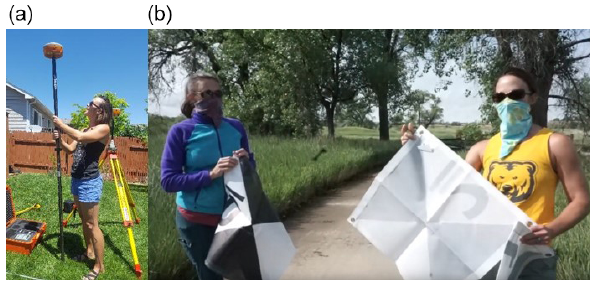
Figure 2. Base and kinematic GNSS methods (a) and example of ground control (b) surveyed for use in GNSS and SfM